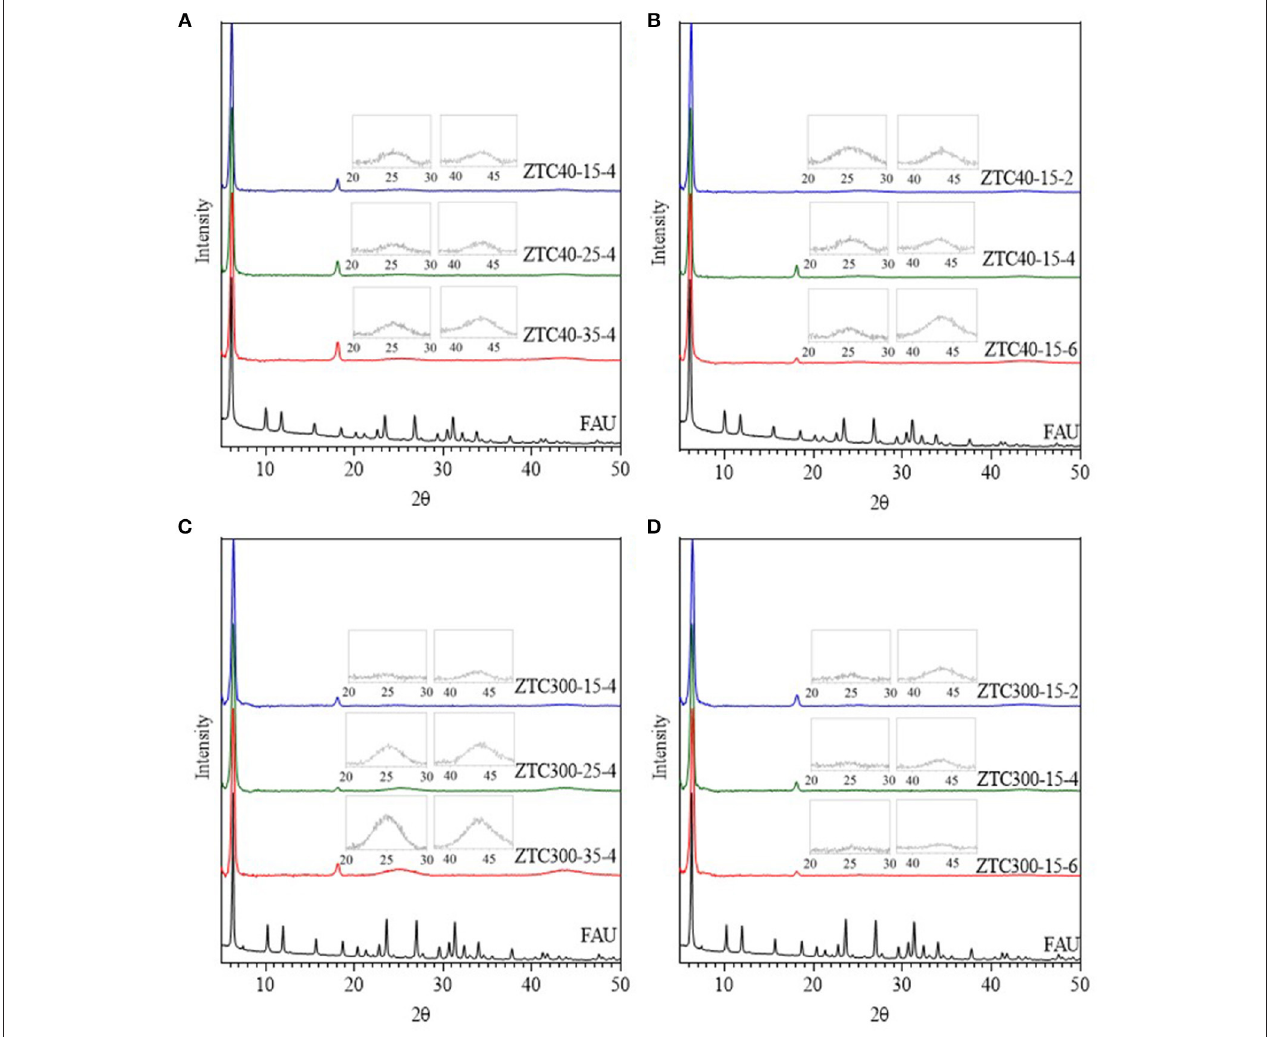
FIGURE 3 | XRD patterns of the liberated carbon at various (A) acetylene concentrations and (B) CVD times for ZTC40, and at various (C) acetylene concentrations and (D) CVD times for ZTC300.